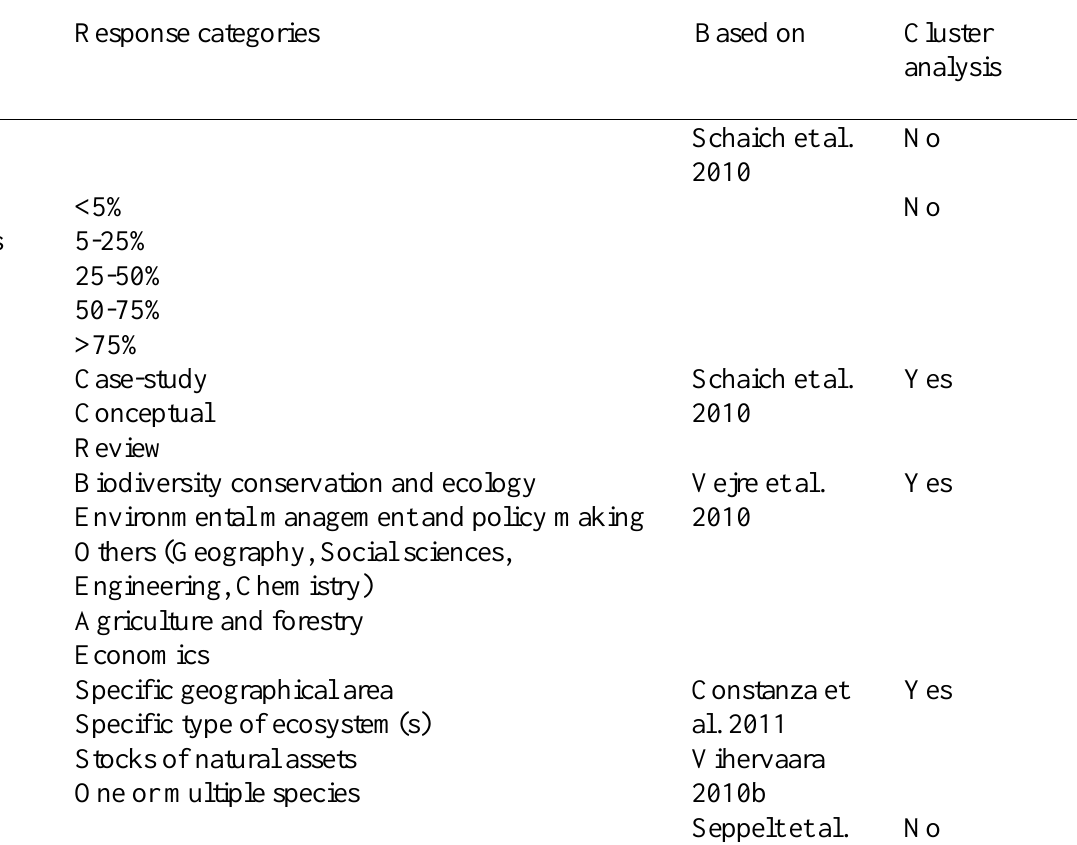
Table A2.1. Set of questions asked for every paper reviewed. The column “Cluster analysis” indicates whether the question was